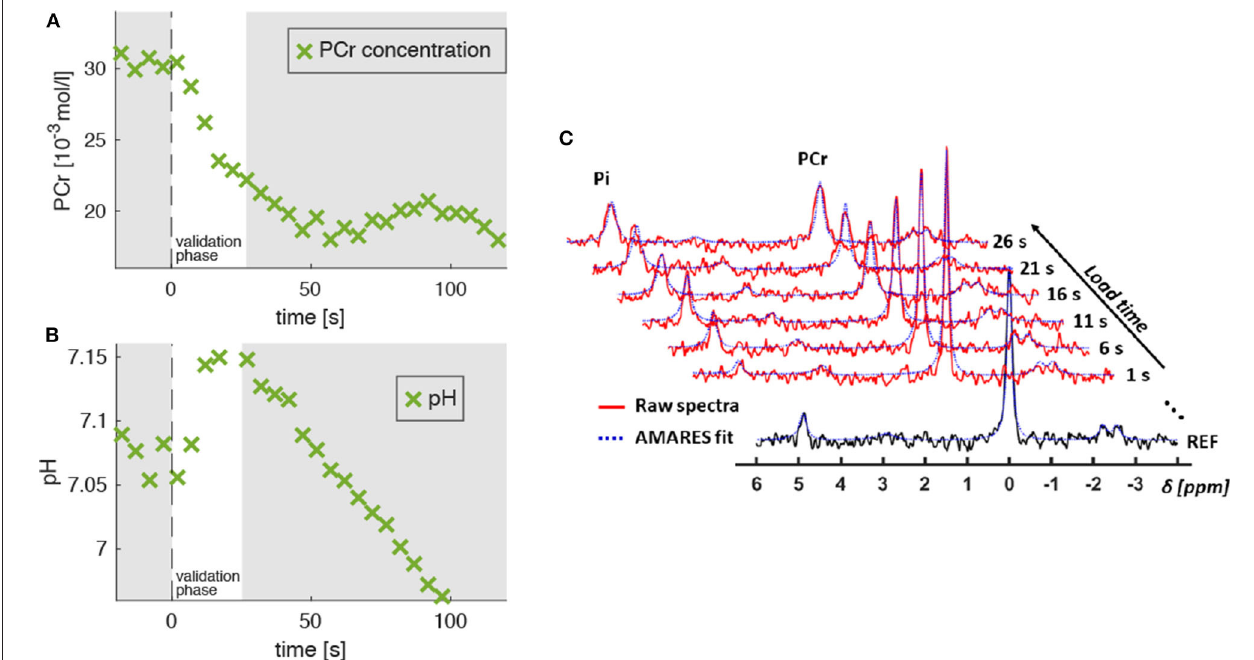
FIGURE 4 | Evolution of PCr concentration ([PCr], A ) and pH level (B) extracted from 31 P-MR spectra, which were acquired in the M. gastrocnemius medialis during dynamic plantarflexion exercise (experiment 3, section 2.3). The time point t = 0s marks the onset of the exercise. Highlighted is the validation phase ( t = 0 ... 25s) for which we hypothesized agreement between experiment and model. During this phase, the PCr concentration reveals a continuous decrease indicating ATP re-synthesis and, thus, energy consumption in the muscle (see section 2.4). During the validation phase the energy supply is dominated by the PCr depletion. The pH decrease for t > 25s reflects the H+ accumulation during the anaerobic glycolysis. Subplot (C) shows the raw spectra (red graphs) and corresponding AMARES fits (blue dashed graphs), obtained during the validation phase. The black graph in the sublot (C) shows a spectrum obtained prior to